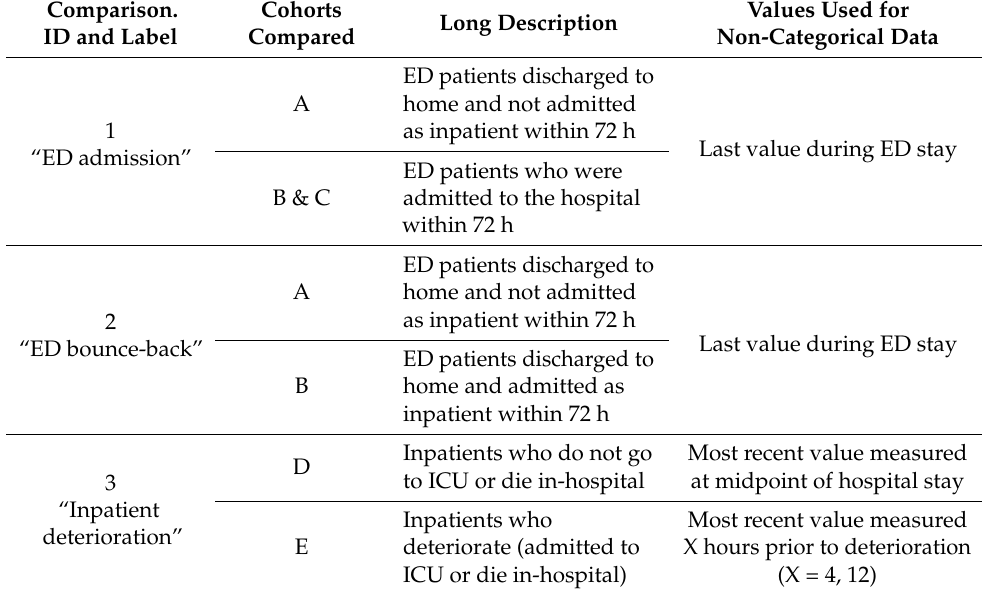
Table 2. Description of comparisons performed.